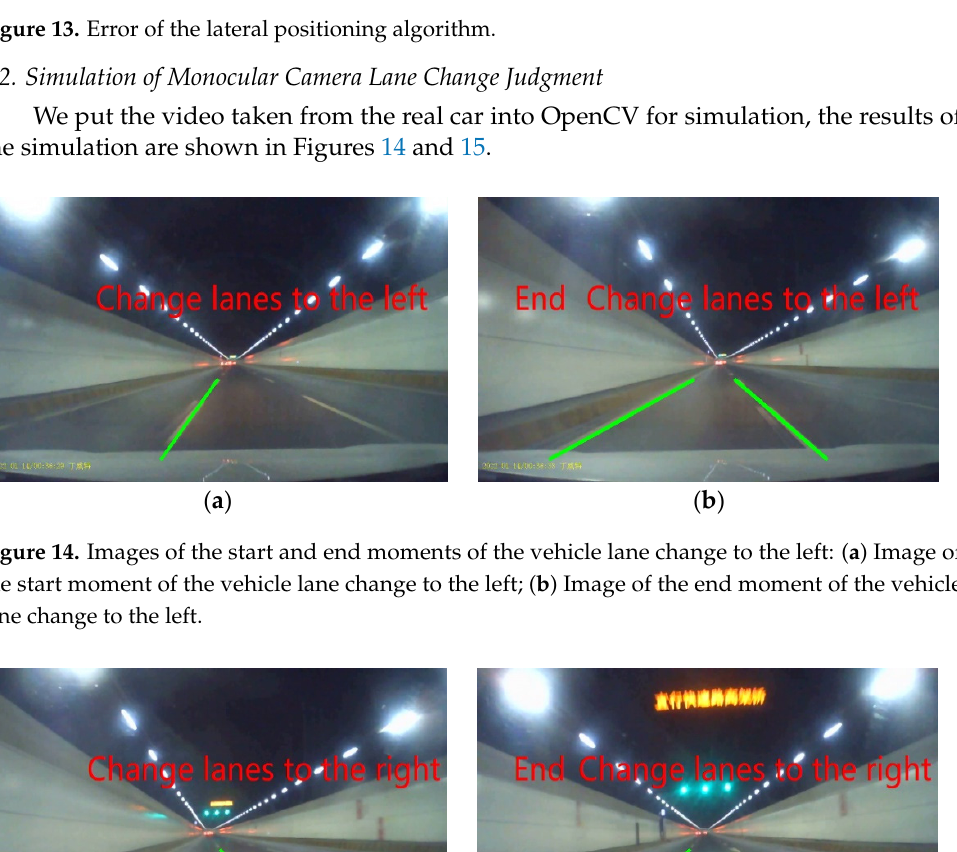
Figure 13. Error of the lateral positioning algorithm.